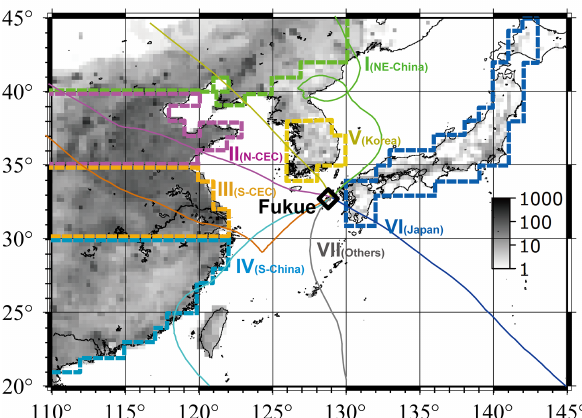
Figure 1. Location of Fukue Island on a black and while contour map, with BC emission rates [ t per month/(0.25 ◦ × 0.25 ◦ grid)] in January 2008 from REAS2 bottom-up inventory (Kurokawa et al., 2013). Borderlines used to classify air mass origin region types are shown by colored broken lines. Example of backward trajectory for each classification is shown by colored solid